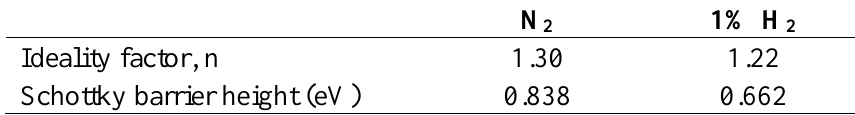
Table 1. Extracted n and  shown in Figure 1. Reproduced with permission from Reference [17]. Copyright The Japan Society of Applied Physics.